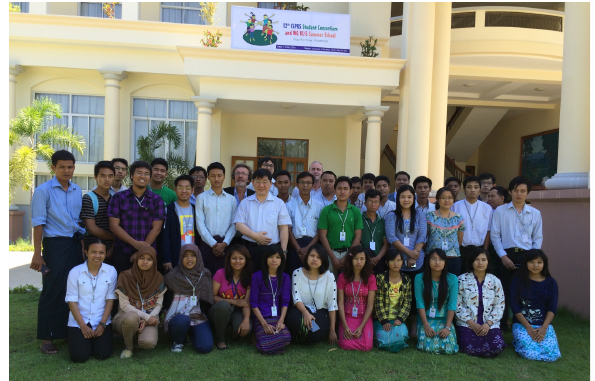
Figure 10. Group photo at the 2014 summer school in Wuhan,